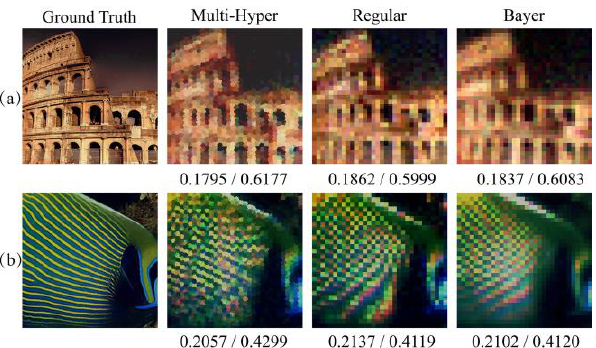
Figure 9. Experimental results of two group scenes. Chromatic images are reconstructed experimen- tally by multi-hyperuniform, regular and Bayer sampling patterns with their RMSEs and SSIMs listed below. ( a ) The scene of Colosseum with color transition area and corresponding reconstructed results in experiments; ( b ) The scene of fish with periodic stripes and corresponding recon-structed